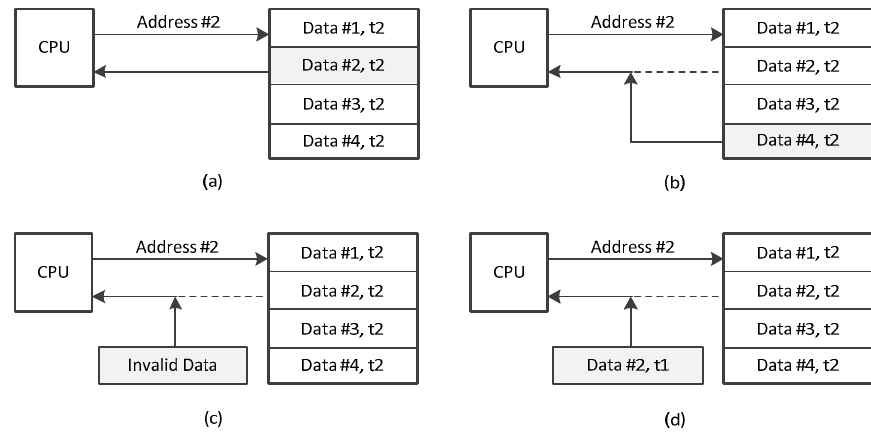
Figure 1. The threat model for the data in embedded systems: ( a ) Valid data access, ( b ) data splicing attack, ( c ) data injection/spoofing attack, and ( d ) data reply attack.